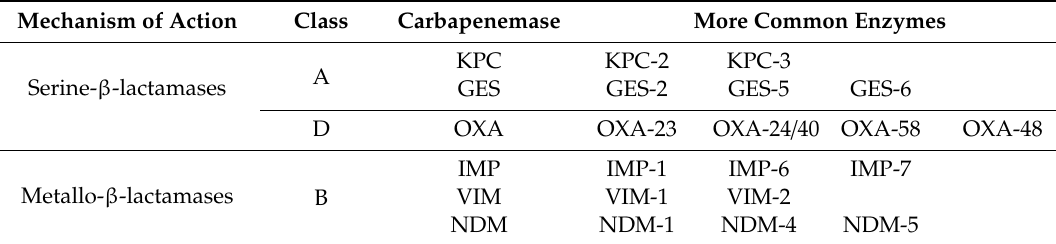
Table 1. Most clinically significant